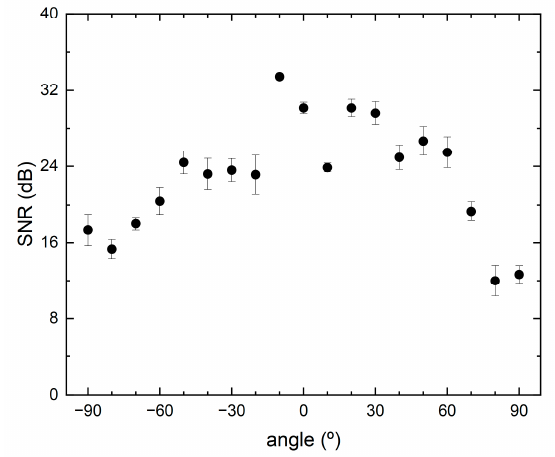
Figure 8. Directional SNR of the sensor for a constant frequency value of 30 kHz.